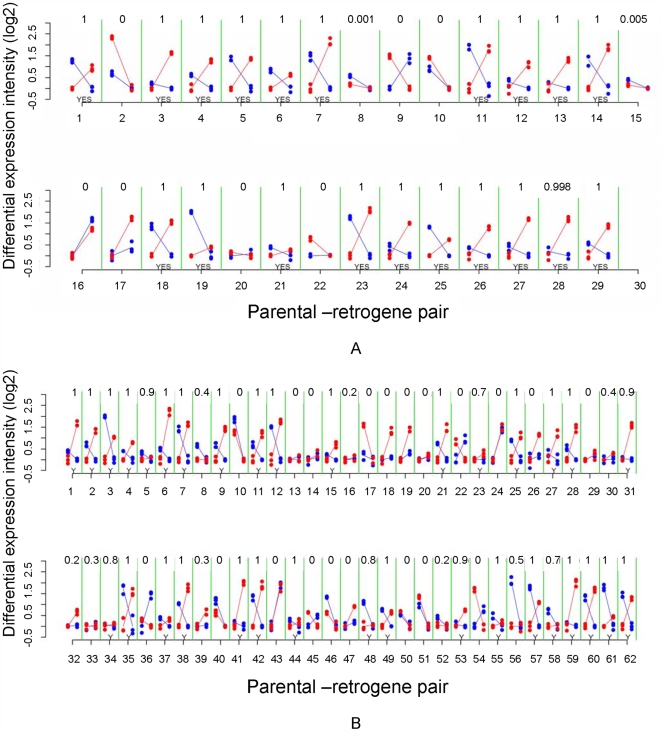
Mitotic and meiotic expression of individual parental-retrogene pairs.(A) Pairs retroposed from X chromosome; (B) Pairs retroposed from autosomes. Differential gene intensity stands for a difference in expression intensities between meiosis and mitosis. Parental genes and retrogenes intensities (log2) are shown in blue and red dots, respectively. Solid lines connect mitosis and meiosis intensity averages of three replicates. The X-axis numbers correspond to parental-retrogene pairs ordered according to Table S2. The numbers on the top of each parental-retrogene segment (between green lines) correspond to the posterior Bayesian probabilities that a pair shows complementary expression (Model B in Statistical Analyses, Methods in Text S1). The bottom yeses (Y) indicate genes where those probabilities are above 50% (Statistical Analyses, Methods in Text S1). Most of X→A parental-retrogene pairs (A) show either a probability of zero or one for complementary expression, whereas several A→A parental-retrogene pairs (B) have probabilities that are markedly different from zero or one (e.g., 0.7 and 0.4). These uncertainties when classifying genes directly affects the confidence intervals, which are much larger for A→A than for X→A parental-retrogene pairs (Figure 5C).